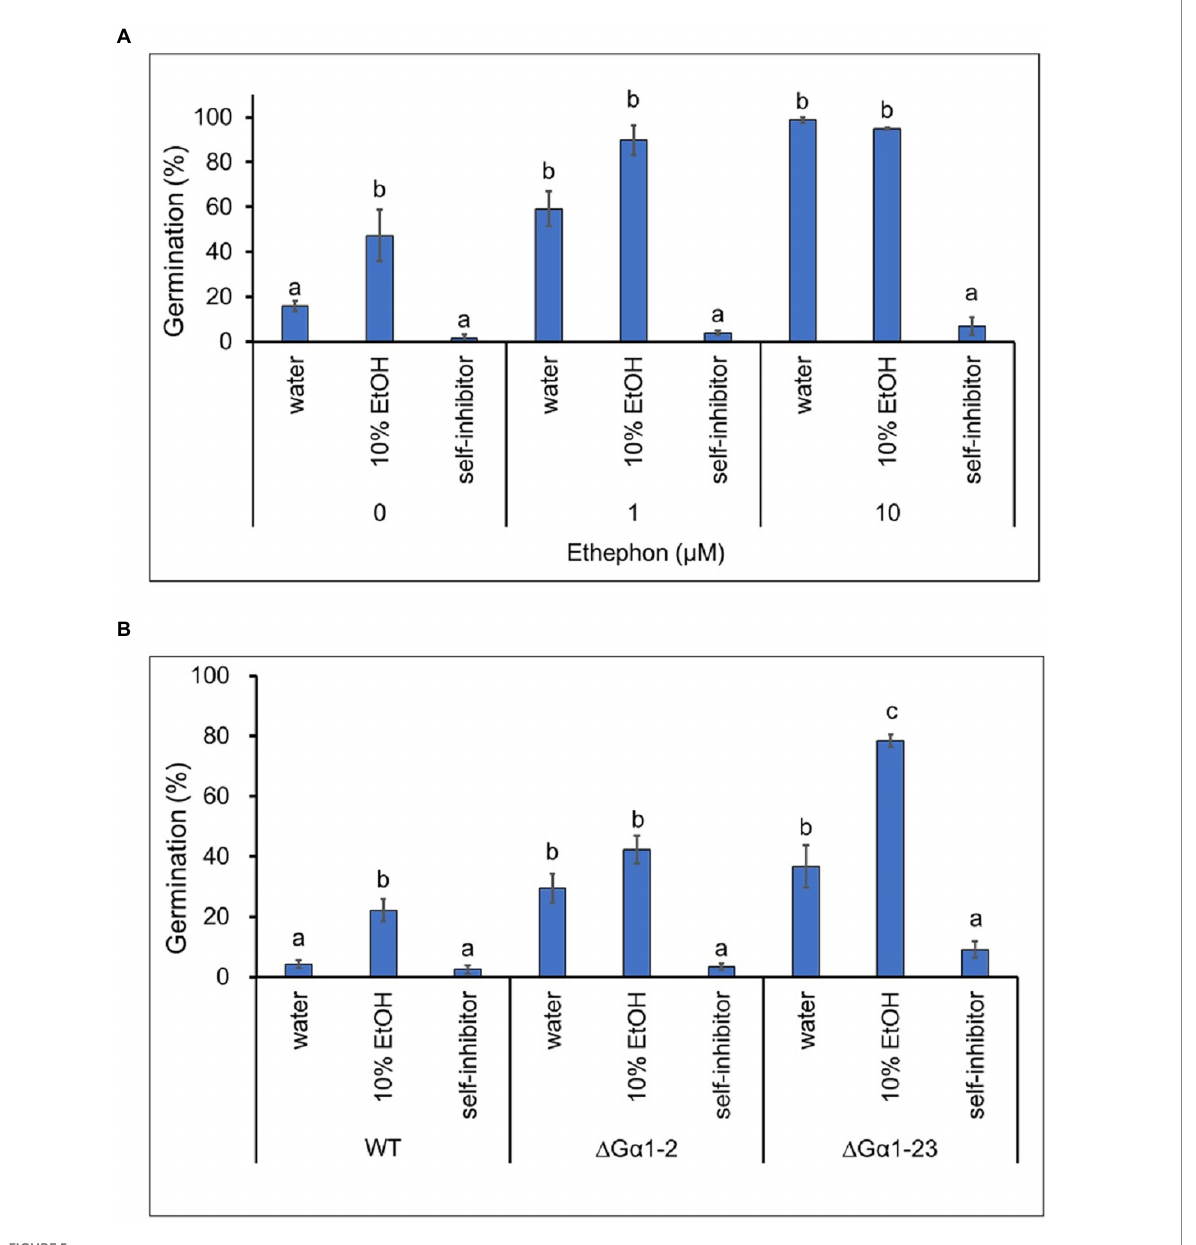
FIGURE 5 Germination self-inhibition assay of partially purified self-inhibitors on plastic petri dishes at 6 h. (A) The effect of self-inhibitors on the germination of Colletotrichum asianum wild-type strain (TYC-2) under 0–10 μ M ethephon treatment. (B) The effect of self-inhibitors on the germination